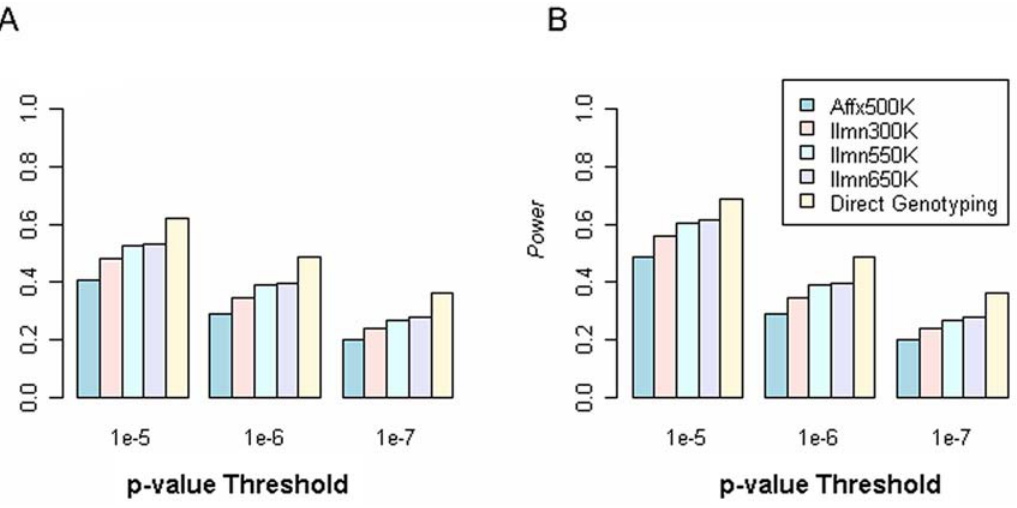
Figure 3. Weighted estimates for statistical power by taking the weighted average of the power on HapMap causal SNPs (weight=2.2/7.5) and that on NonHapMap causal SNPs (weight=5.3/7.5). (A) Kruskal-Wallis tests. (B) Spearman rank correlation tests. Further, we quantified the power of ‘‘direct genotyping,’’ where association tests were conducted on causal SNPs. This represents an upper bound on statistical power in